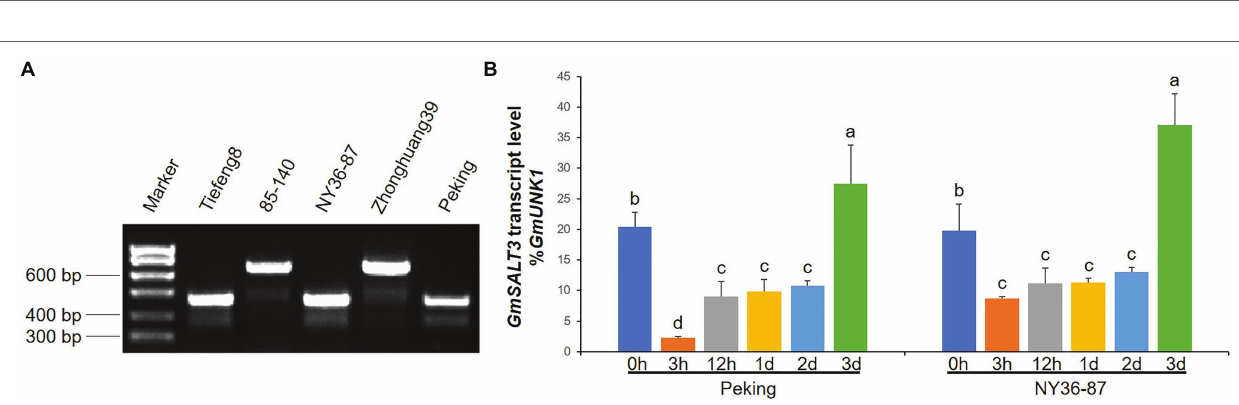
FIGURE 5 | Evaluation of GmSALT3 in parental lines. (A) Genotype confirmation of GmSALT3 in parental lines using gene-specific marker H2-Insl, salt-tolerant cultivar Tiefeng 8, and salt-sensitive cultivar 85–140 as control accessions. (B) Expression of GmSALT3 in roots of NY36-87 and Peking at different time points after 200 mM NaCl treatment. GmUKN1 was used as the internal reference gene. Letters indicate significant differences between samples (Dunan’s multiple range test at p < 0.05). Different letters indicate statistically significant differences of gene expression (one-way ANOVA using Fisher’s LSD test, p <